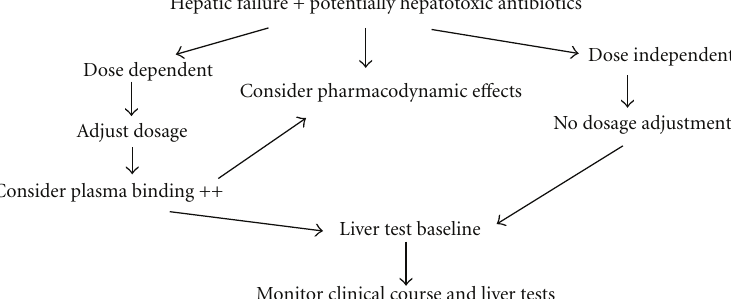
Figure 1: Algorithm for drug dosing in liver failure. Possibly avoids drugs which are metabolized by liver and/or have potential hepatotoxi- city.